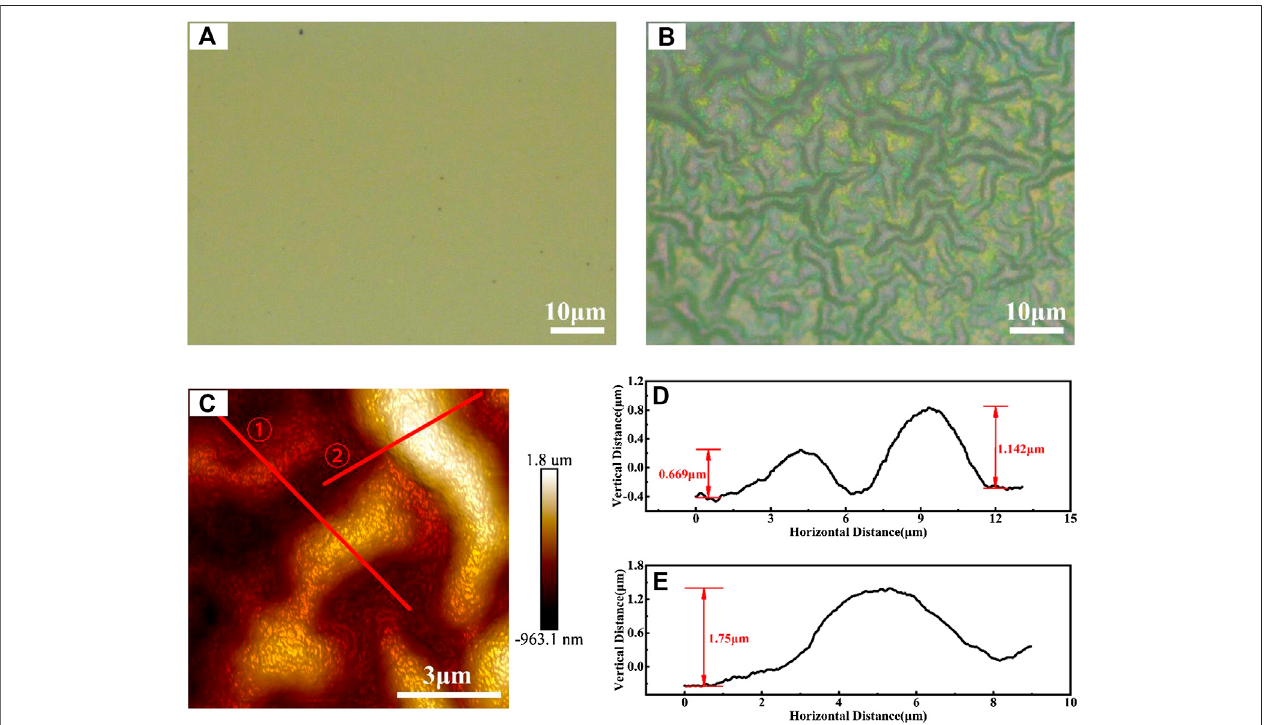
FIGURE3|(A,B) TheopticalmicroscopeimagesofthesurfaceofthebulkLNcrystalwithnickel fi lmbefore (A) andafterannealing (B)(C) AFMtopographicimage of the wrinkles, and (D) – (E) AFM height pro fi les along the solid red line one and line two in (C)